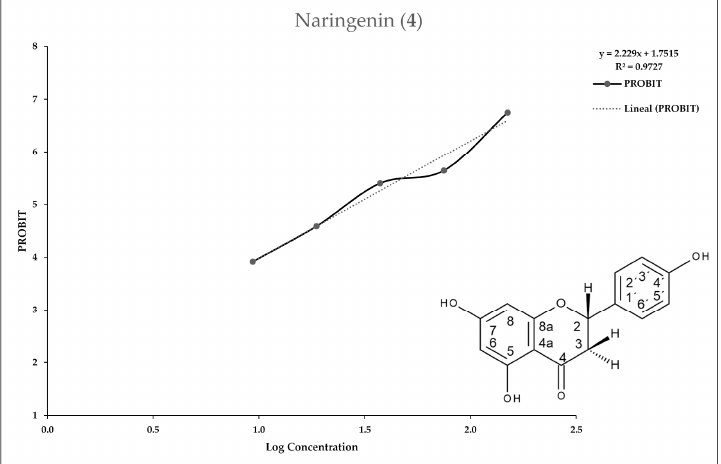
Figure 5. Antiprotozoal activity of Naringenin 4 against Entamoeba histolytica . Growth inhibition of 96.50% at 150 µg/mL, IC 50 = 28.86 µg/mL.